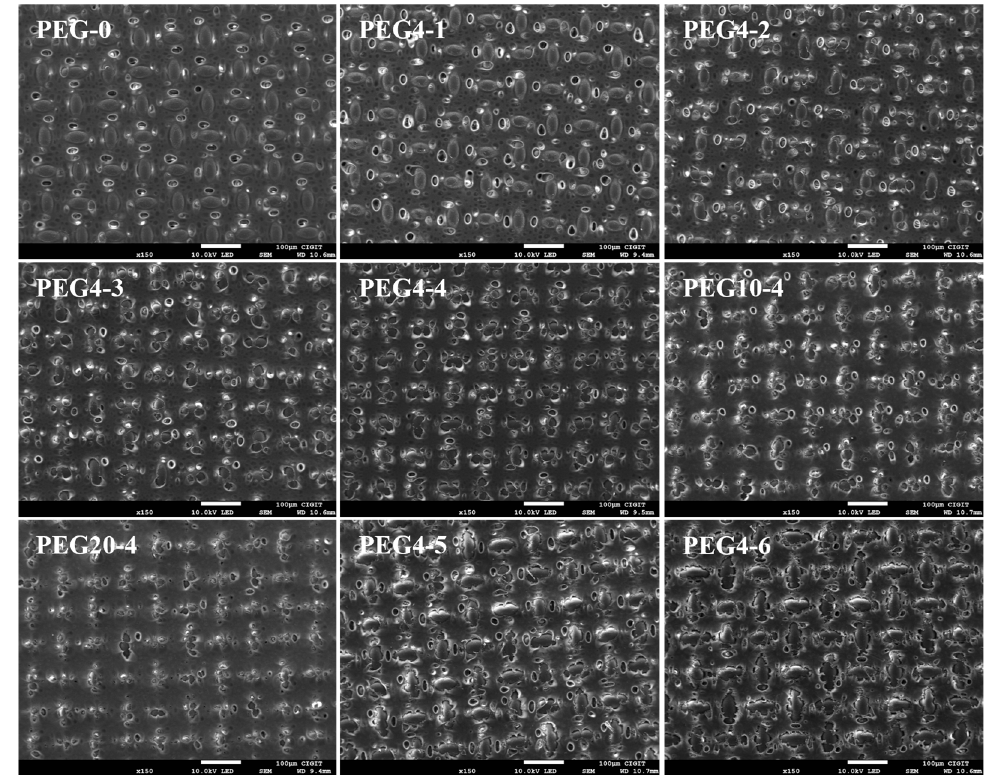
Figure 4. SEM images for the bottom of PSU and PSU/PEG substrates.